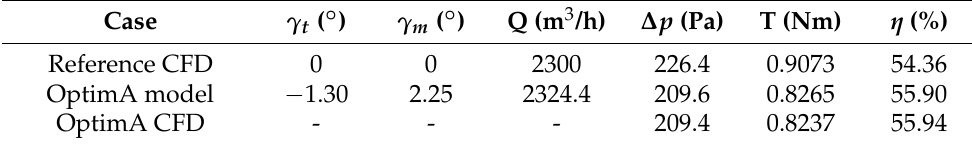
Table 1. Comparison between the reference design and the optimum on